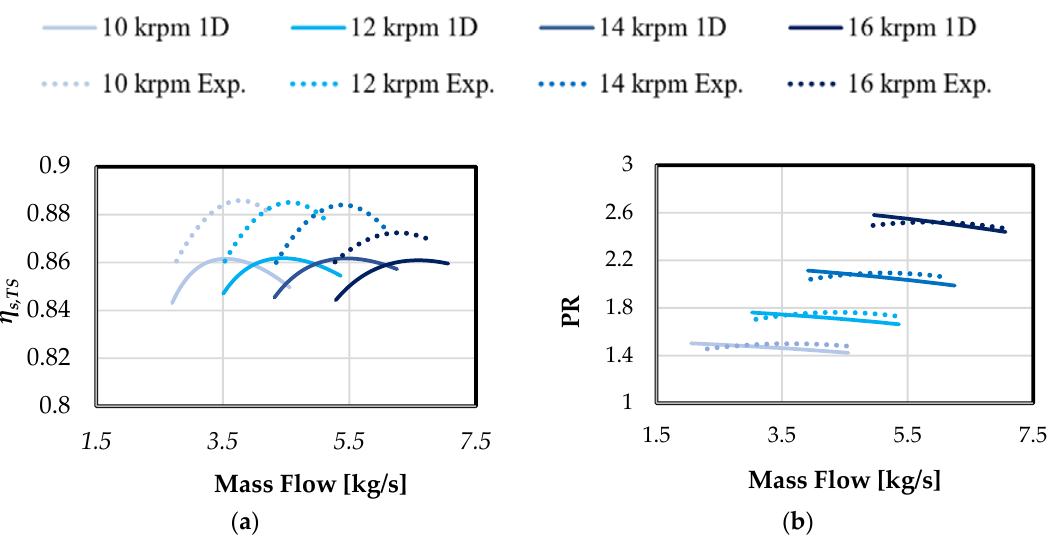
Figure 5. Compressor validation: characteristic maps for Eckardt impeller O. ( a ) Total to static isentropic efficiency vs mass flow rate; ( b ) pressure ratio vs mass flow rate.